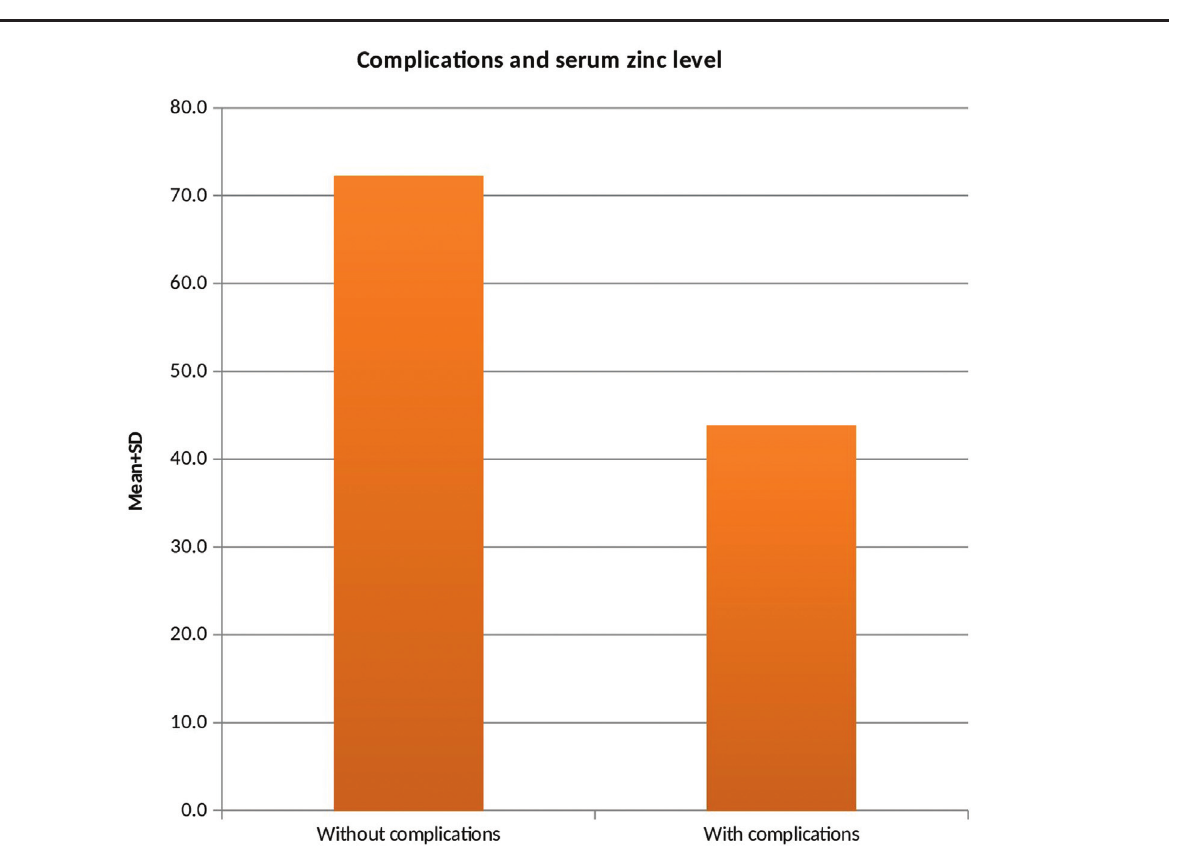
Comparison of serum zinc level according to complications among patients ( N =